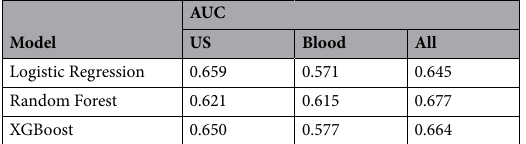
Table 2. AUCs for predicting relapse in RA patients using US examination data, blood test data, or all data calculated by each model. RA rheumatoid arthritis, US ultrasound, AUC area under the curve.